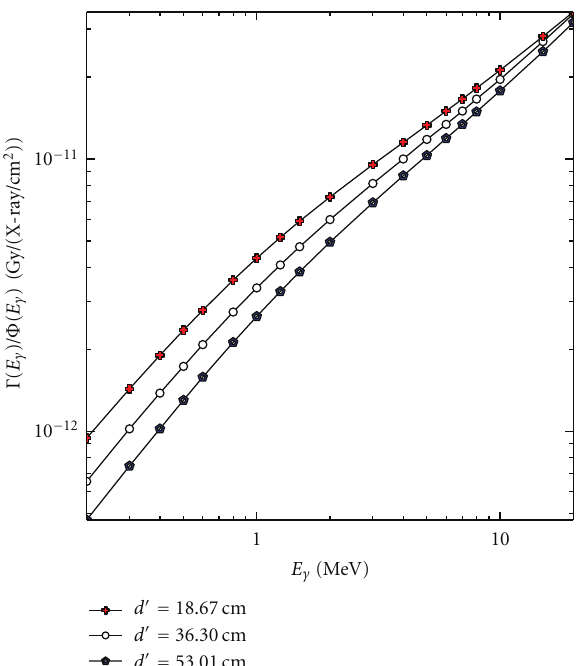
Figure 4: Fluence-to-mean-dose-in-water conversion factors / Φ ( E Γ ( E γ ) γ ) used in calculating the energy response of CPID. The mean dose in water is defined as the integral of depth-dose curve along the depth axis normalized to the thickness of the water slab.